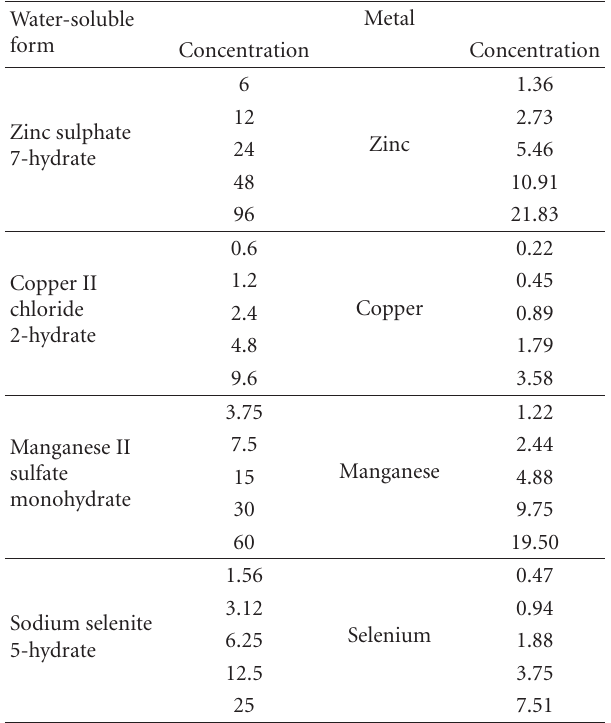
Table 1: Nominal concentrations (mg/L) of the four salts of metal, used as water-soluble forms, and the corresponding nominal con- centrations (mg/L) of the four metals considered in the current study.